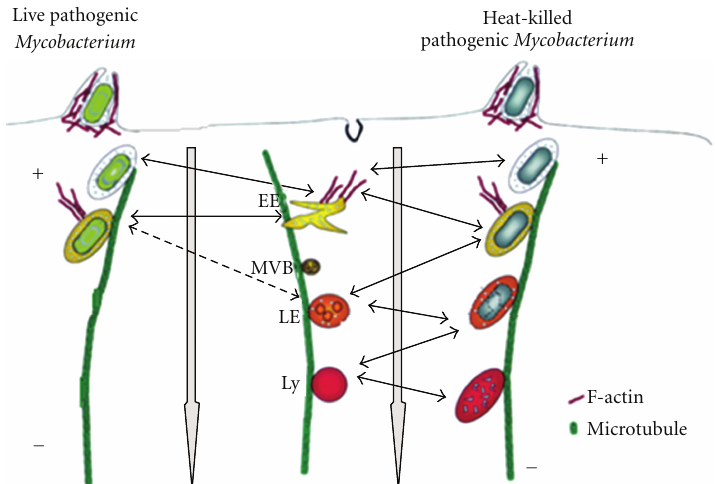
Figure 1: Maturation process of pathogen-containing phagosomes. Diagram outlining the di ff erences between endosome progression to lysosome (center), maturation of a phagosome harboring a live pathogen, for example, M. tuberculosis H37rv (left) and a phagosome harboring a dead pathogen (right). The fusion processes of phagosomes containing live/dead pathogens with compartments of the endosomal pathway are indicated by bold arrows. The traced arrows indicate inhibition of the fusion events between the phagosome harboring the live pathogen and the endocytic compartment. The diagram also illustrates the importance of two components of the cell’s cytoskeleton in phagosome maturation. Actin is recruited to the phagocytic cup and might nucleate on the phagosome membrane during the maturation process. The microtubules, to which endocytic vesicles and phagosomes are thought to bind during the maturation process, are also represented. EE: early endossome; MVB: multivesicular bodies; LE: late endosome; LY: lysosome. Diagram adapted from